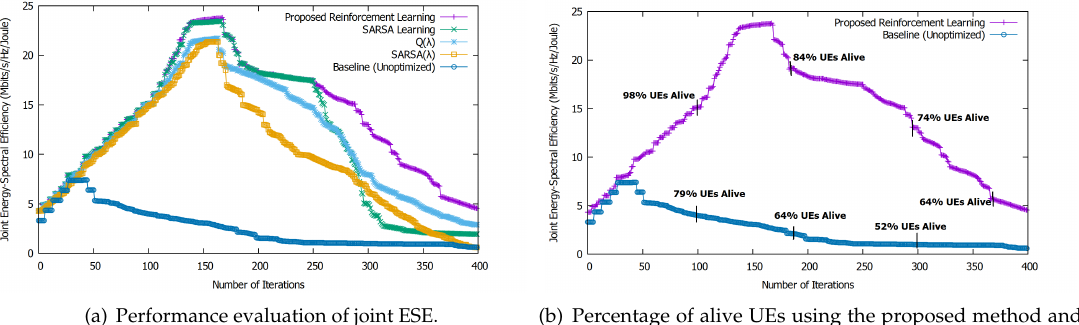
Figure 6. Performance evaluation of joint ESE and percentage of alive UEs. ( a ) Performance evaluation of joint ESE. ( b ) Percentage of alive UEs using the proposed method and baseline